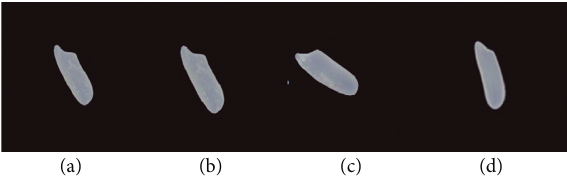
Figure 1: Images of the four varieties of rice. (a) Thai jasmine, (b) jasmine sticky, (c) Simiao, and (d) Northeast